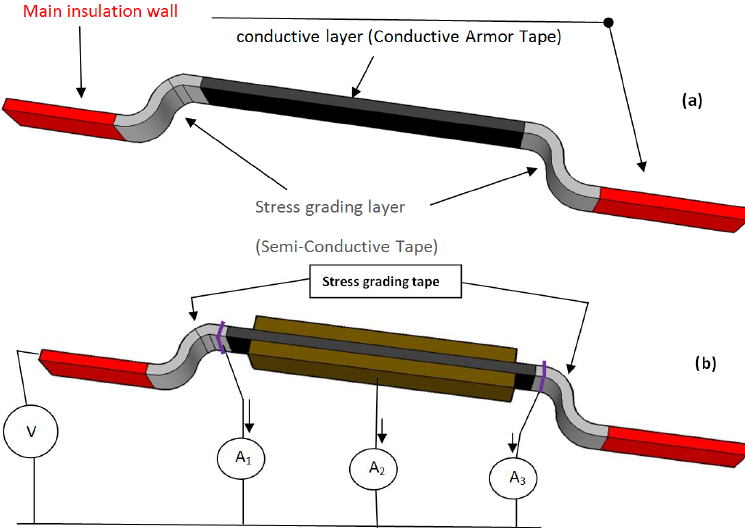
Figure 20. One half of a coil ( a ) containing all the elements. In ( b ), the strands are powered by a high voltage supply and all the leakage currents can be measured. In particular, A 1 and A 3 are leakage currents induced by the stress-grading. There are extracted by the guard electrodes and do not disturbed the measurement A 2 which is the leakage current of the main insulation wall. Without the guard electrodes, the current measured by A 2 , will include A 1 and A 3 .